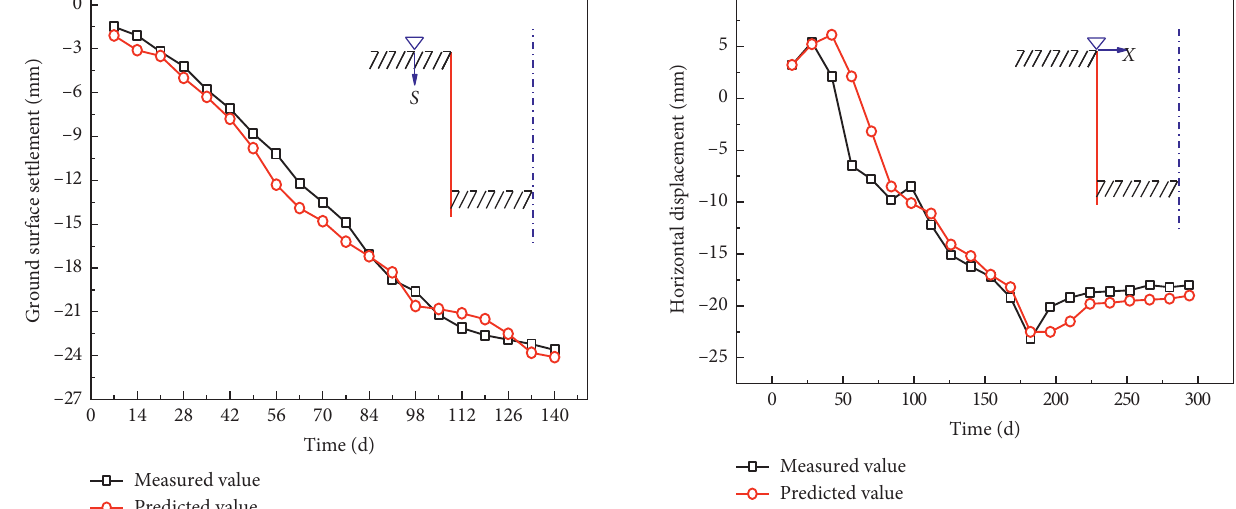
Figure 9: Maximum horizontal displacement curve of wall